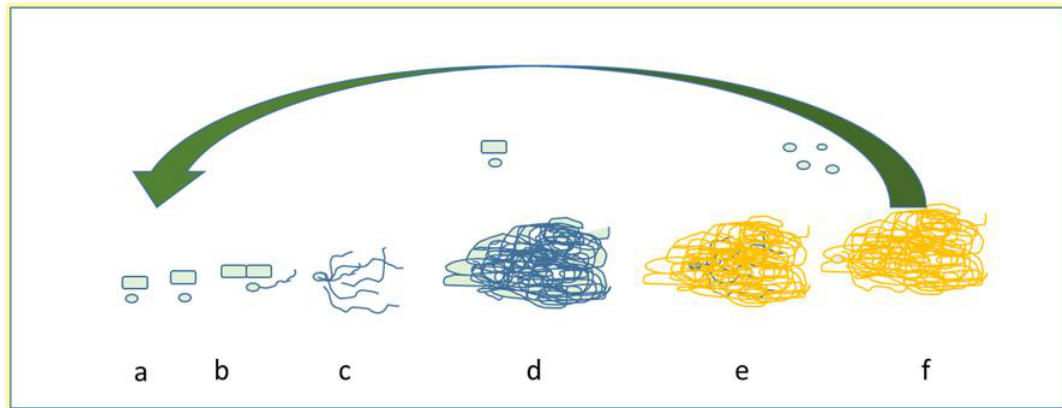
Figure 2. Model of biofilm development in filamentous fungi: ( a ) adsorption, ( b ) active attachment, ( c ) the first formation of microcolony through the process of germination and/or the development of a monolayer, ( d ) the development of mycelia, ( e ) the maturation of fungal biofilm, and finally ( f ) dispersion of conidia and/or and/or arthroconidia (modified from [77,88]). The steps generally include: (a) propagule adsorption, which involves contact of spores, hyphal fragments, or sporangia to a surface; (b) active adhesion, in which spores secrete proteins adhesins